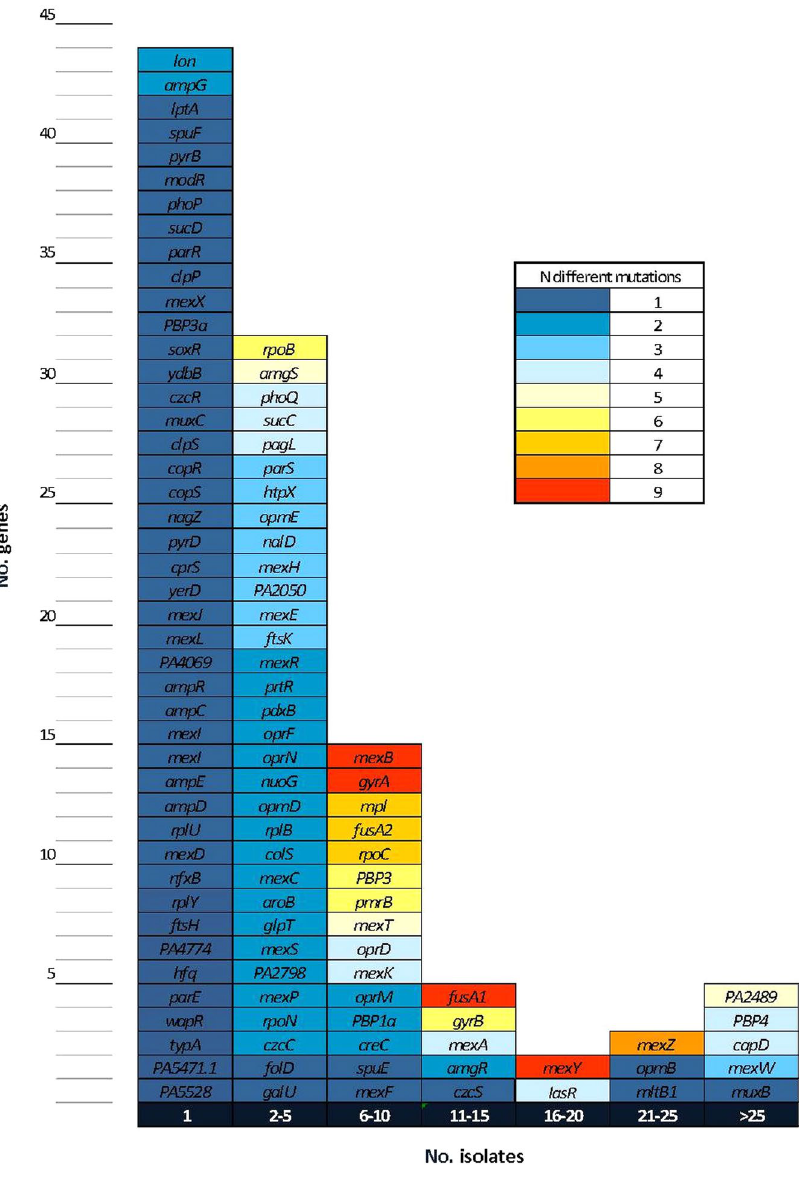
Figure 4. Distribution of mutations among the CC274 collection. Mutations encountered among the 164 antibiotic resistance related genes are represented, synonymous and common non-synonymous mutations have been